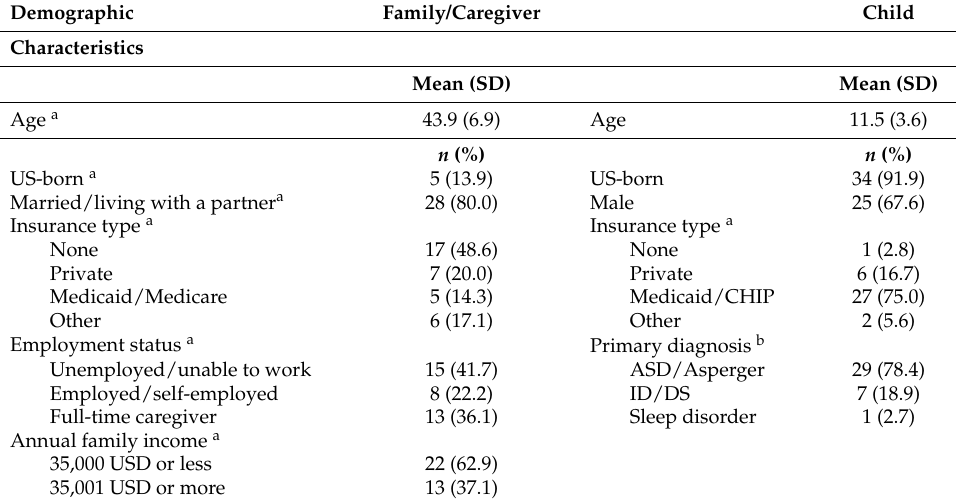
Table 1. Family/caregiver ( N = 37) and child ( N = 37) demographic characteristics.